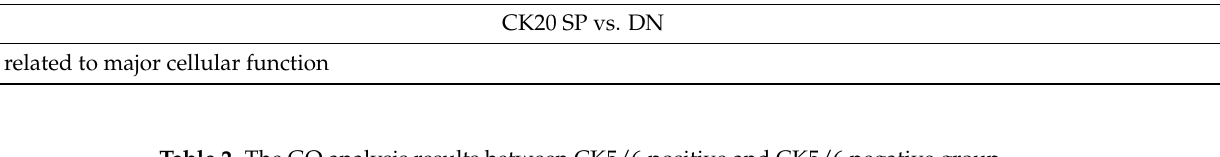
Table 2. The GO analysis results between CK5/6 positive and CK5/6 negative group.